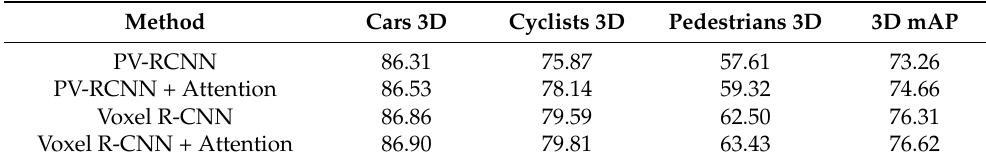
Table 4. A comparison of 3D object detection results (mAP) in the KITTI validation set before and after adding the attention module.